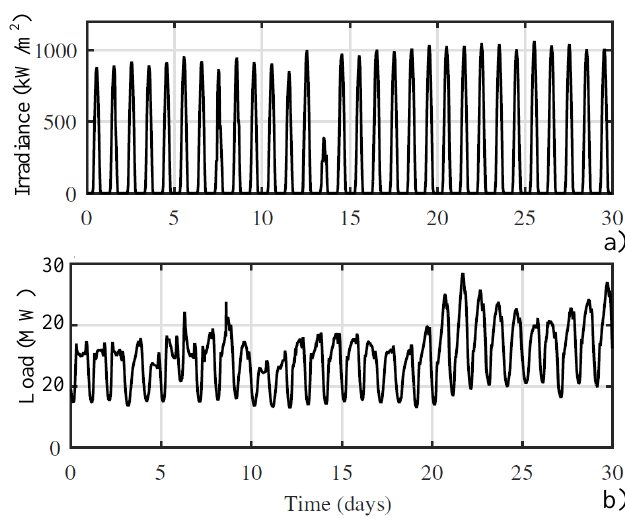
Figure 5. 30-day, hourly solar irradiance ( a ) and load ( b ) time series.